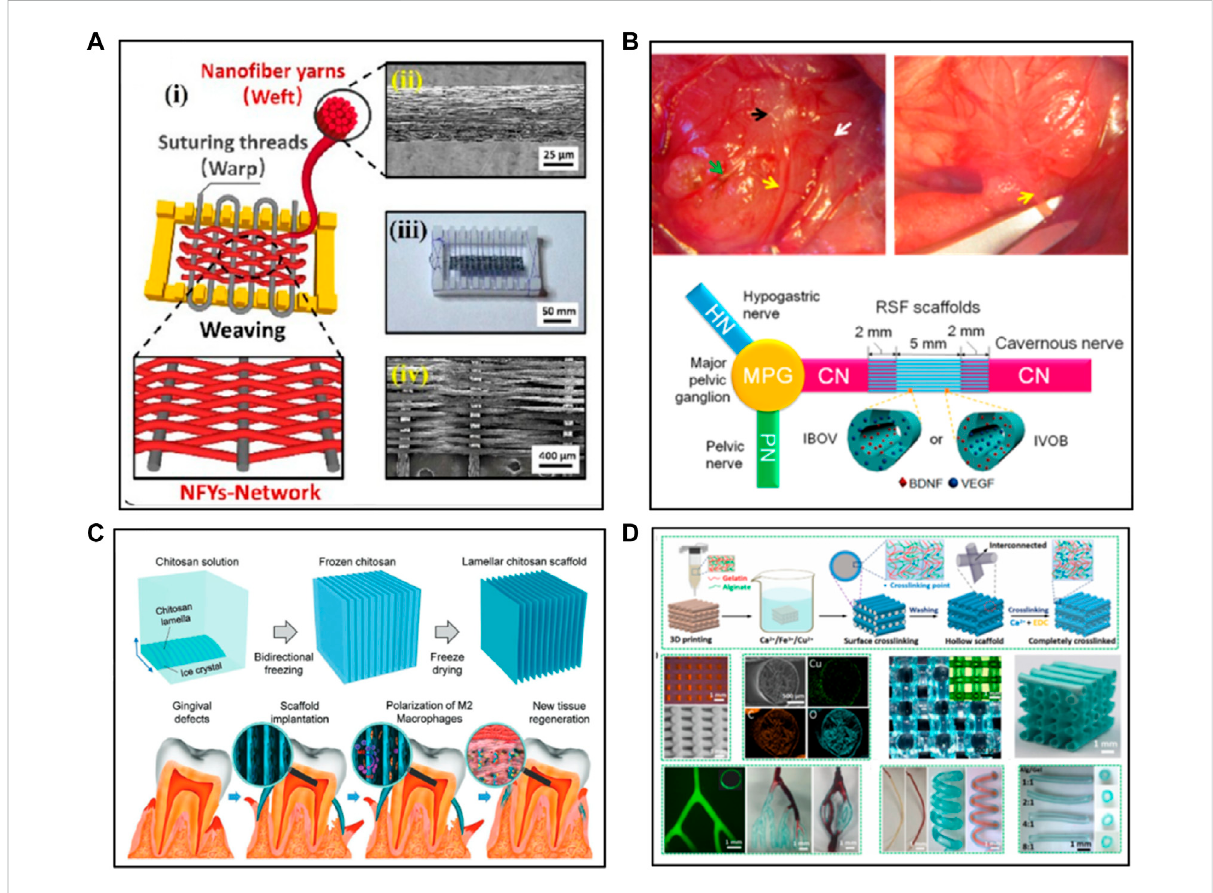
FIGURE 1 The fabrication of natural polymer-based scaffolds via various methods: (A,B) Electrospinning. (C) Freeze-drying and (D) 3D printing. The pictures got permissions from (Zhang et al., 2016), (Wu Y. et al., 2017), (Feng et al., 2021), (Luo et al., 2022),